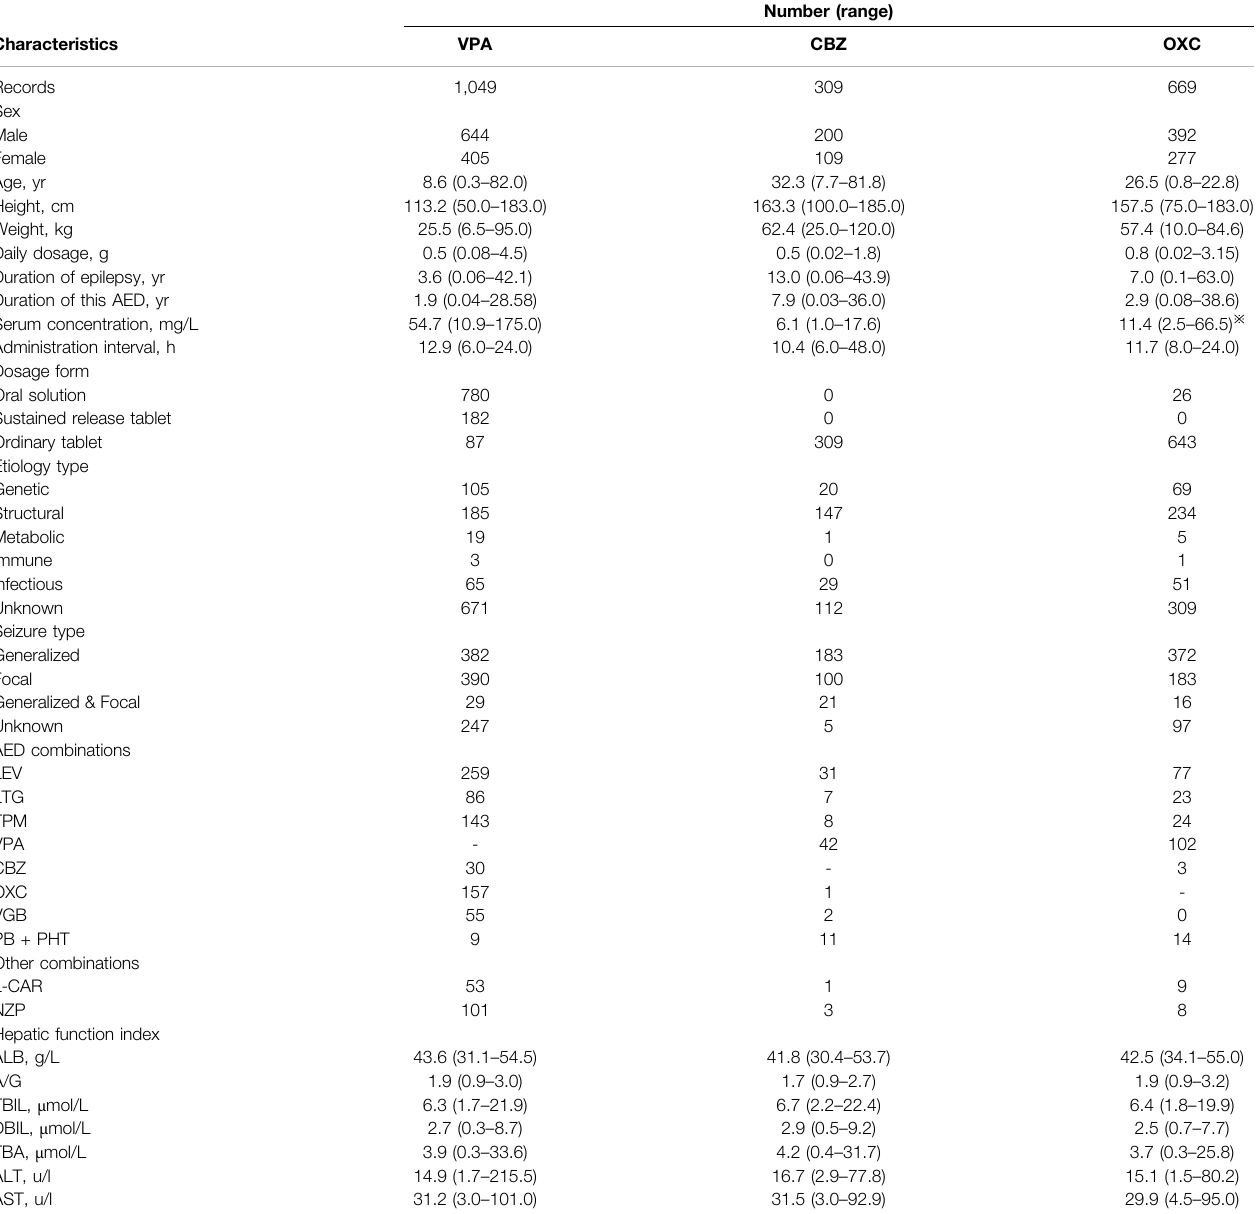
TABLE 1 | Clinical characteristics of the study